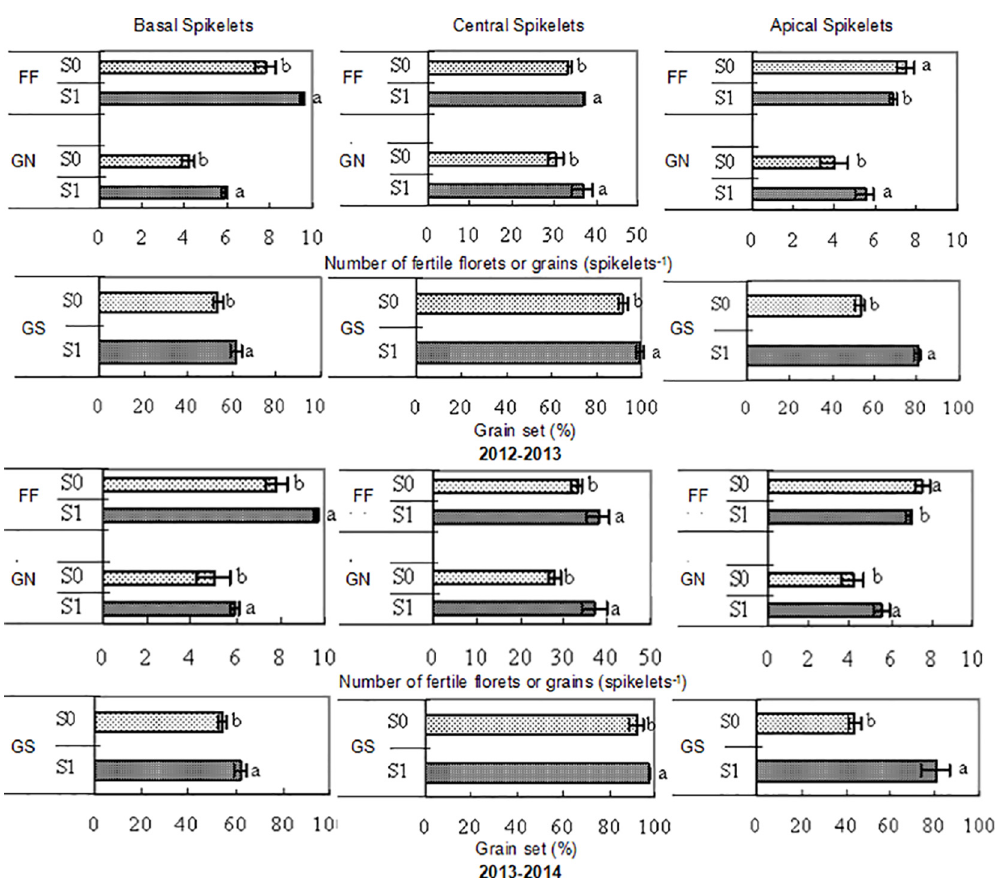
Fig 4. The number of fertile florets at anthesis (FF), grain number at maturity (GN), and percentage of grain set (GS) in winter wheat in response to two foliar spray treatments (S0: water [pale grey bars]; S1: 6-BA [dark grey bars]) in three spikelet categories (basal, central and apical). The data are presented as the treatment mean ± standard error, n = 3. The different letters indicate significant differences at a P <